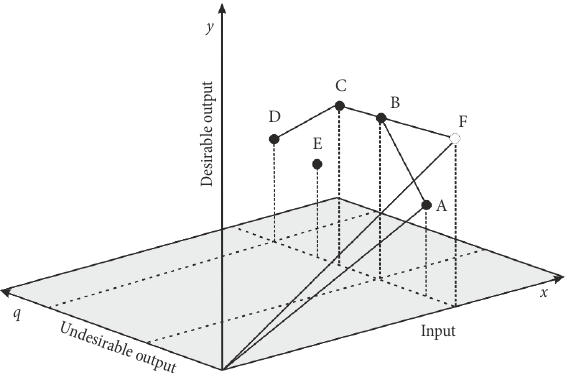
Fig. 6. Production set with one input, one desirable output, and one undesirable output